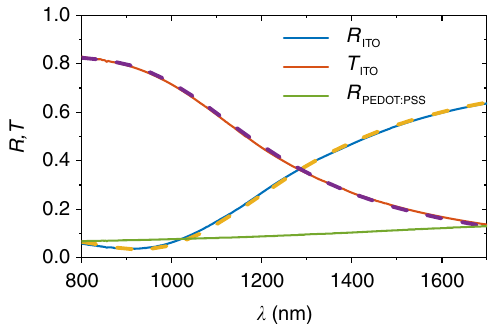
Fig. 4 Re fl ectance ( R ) and transmittance ( T ) of ITO and the re fl ectance of PEDOT:PSS. Materials were measured on glass (solid lines) and the fi ts (dashed lines) to the ITO data for the determination of n and k values. ITO shows a strong increase in re fl ectance for wavelengths longer than 1000